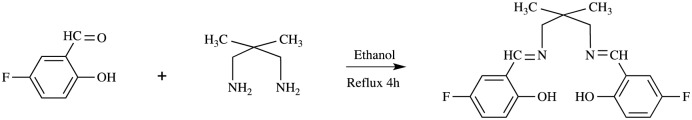
Synthesis of L2F.